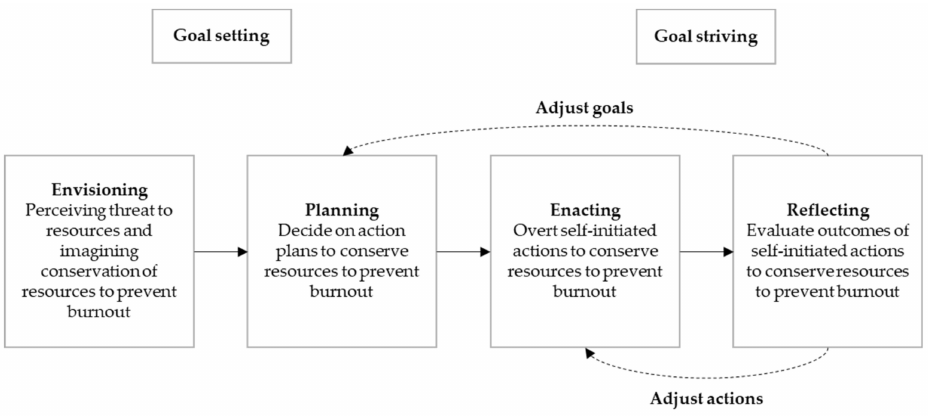
Figure 1. Model of proactive burnout prevention process (adapted from Parker et al.,